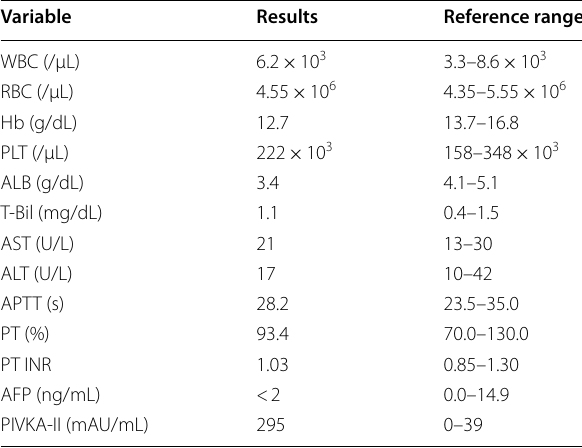
Table 1 Preoperative data Table 2 Coagulation data at the onset of coagulopathy